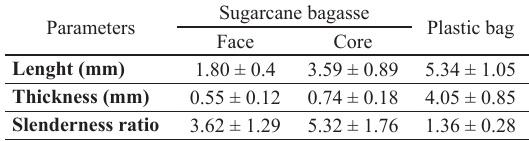
Table 1. Sugarcane bagasse and plastic bag particles characterization. Parameters